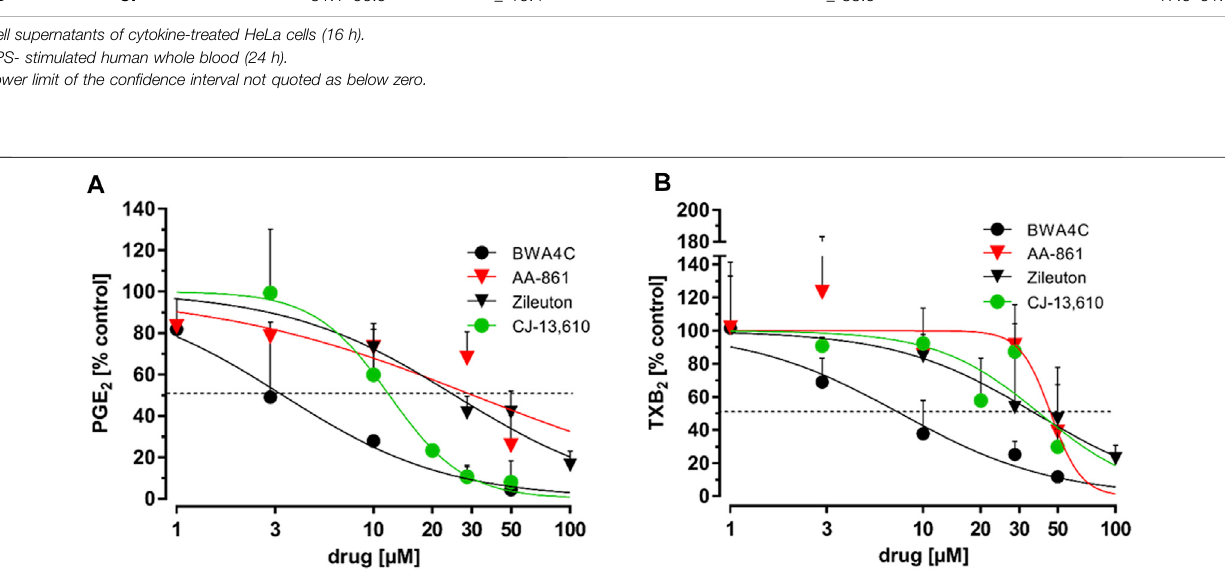
FIGURE3| InhibitionofPGE 2 andTXB 2 inLPS-stimulatedhumanwholeblood.FreshlydrawnhumanwholebloodwasstimulatedwithbacterialLPS(10 μ g mL − 1 , 24 h). Simultaneously, the blood was treated with increasing concentrations of AA-861, BWA4C, zileuton or CJ-13,610. Plasma PG concentrations were assessed by LC-MS/MS.Fordetailedmethodicaldescriptions,seetheMaterialsandMethodssection.MeanPGformationinhumanwholeblood:PGE 2 34.36 ± 8.29 ng mL − 1 ,TXB 2 15.89 ± 6.60 ng mL − 1 ; Values represent the mean + SD of three independent